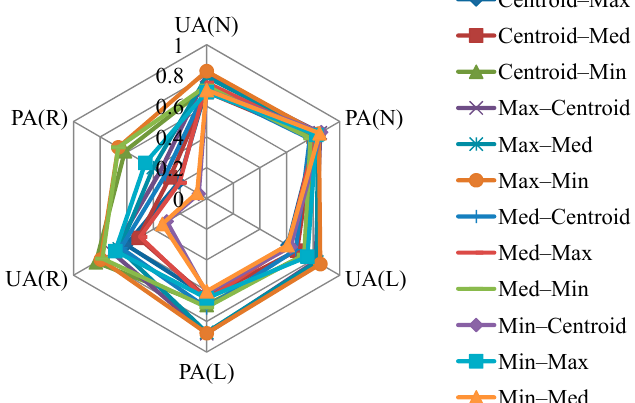
Figure 7. Quantitative evaluations of Model-1 using the hybrid sampling strategies and the area constraint ( ≥ 1000 m 2 ). For example, Centroid–Max indicates that the source and run-out samples are extracted by the centroid and maximum operators, respectively.